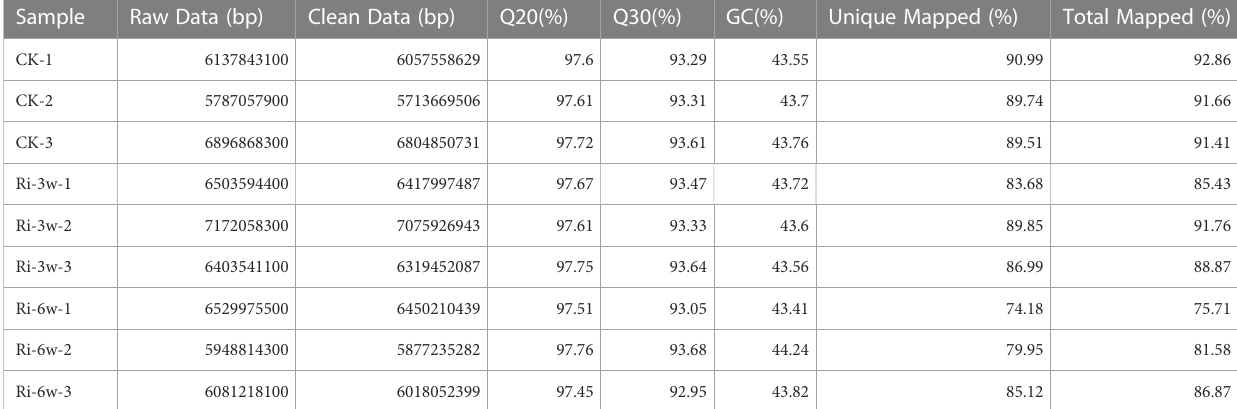
TABLE 1 Summary of throughput and quality Illumina-based transcriptome sequencing of cassava roots during AM symbiosis.